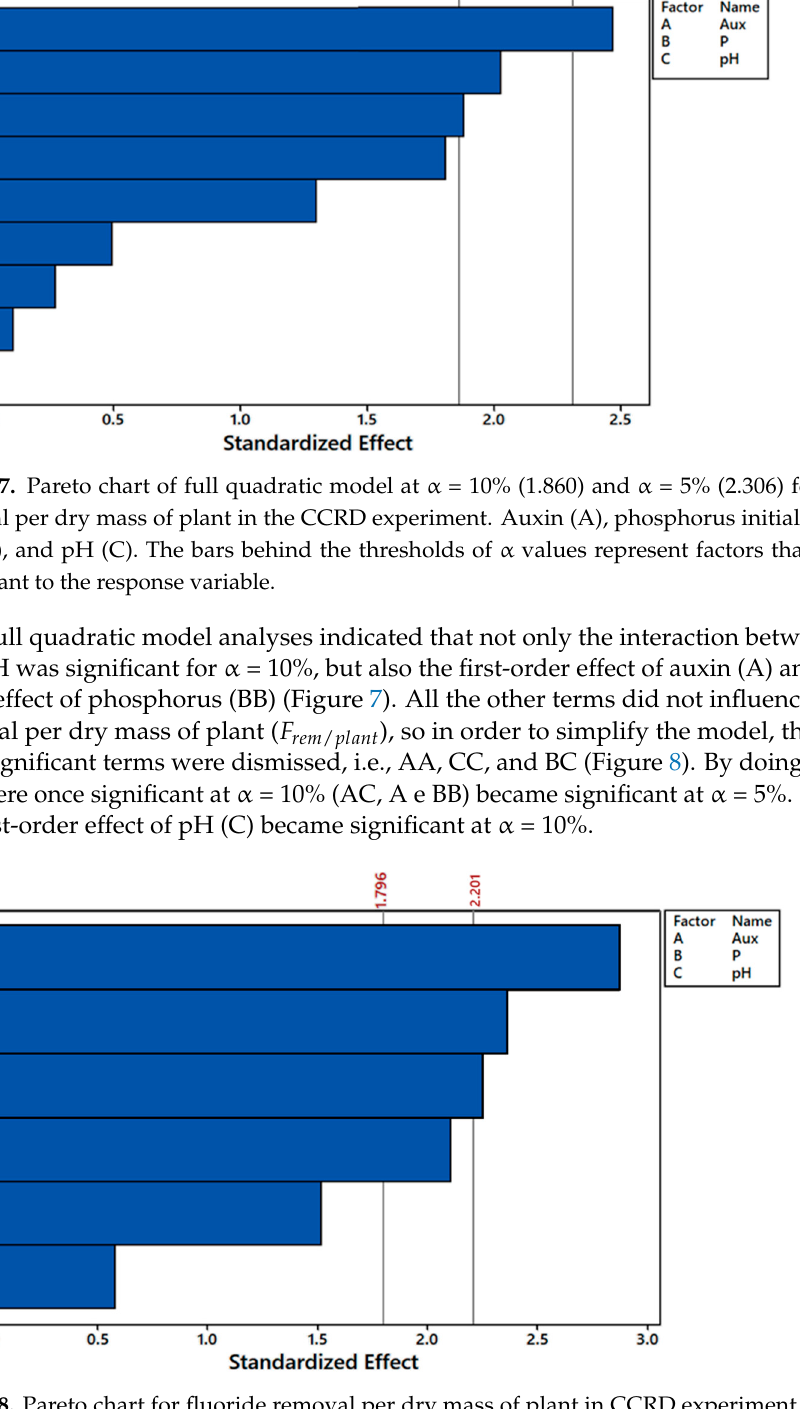
Figure 8. Pareto chart for fluoride removal per dry mass of plant in CCRD experiment at α = 10% (1.796) and α = 5% (2.201), disregarding BC, CC, and AA terms from full quadratic model. Auxin (A), phosphorus initial concentration (B), and pH (C). The bars behind the thresholds of α values represent factors that were not significant to the response variable.